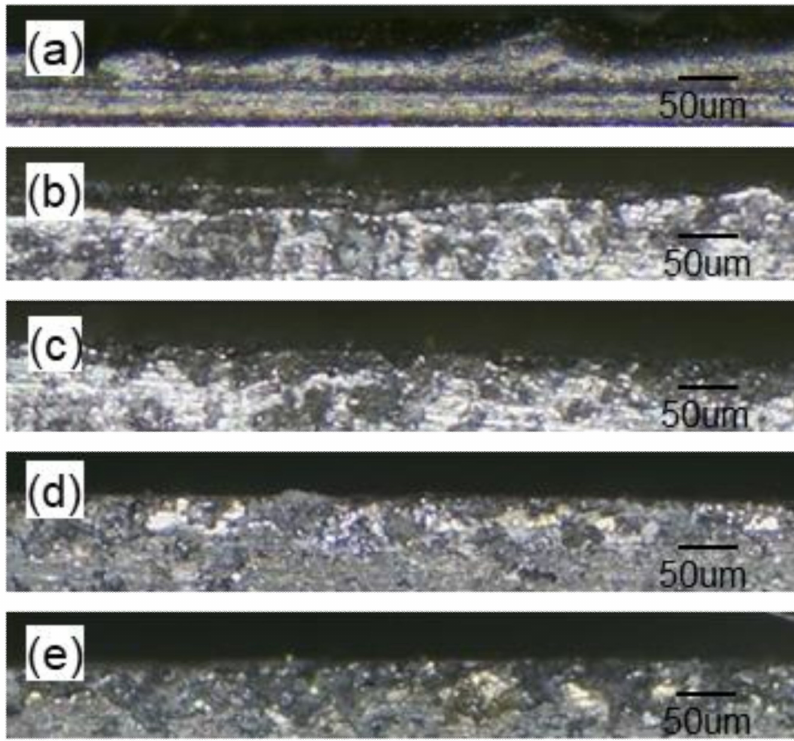
Figure 9. Comparison of edges: ( a ) GM; ( b ) GE/DM; ( c ) ZUE/DM; ( d ) XUE/DM; ( e ) 2UE/DM.